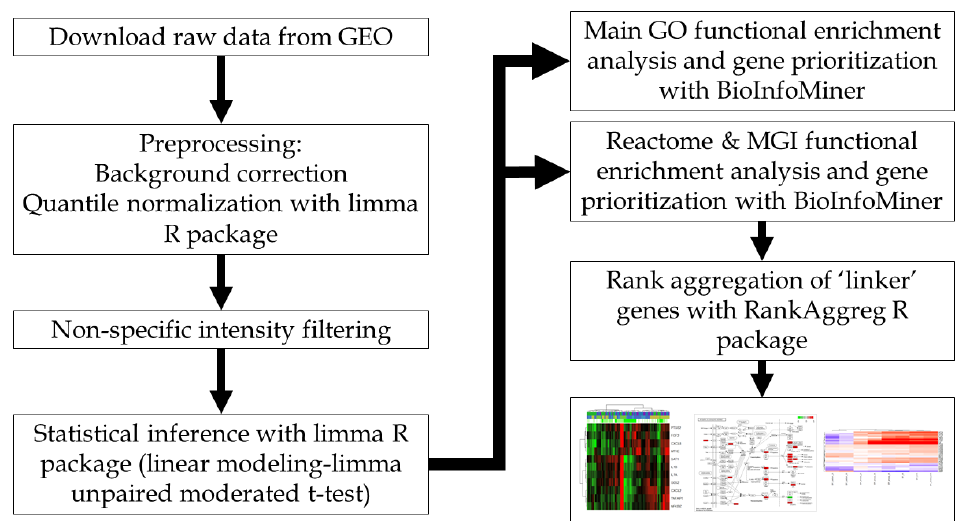
Figure 4. Computational pipeline of bioinformatic analysis.